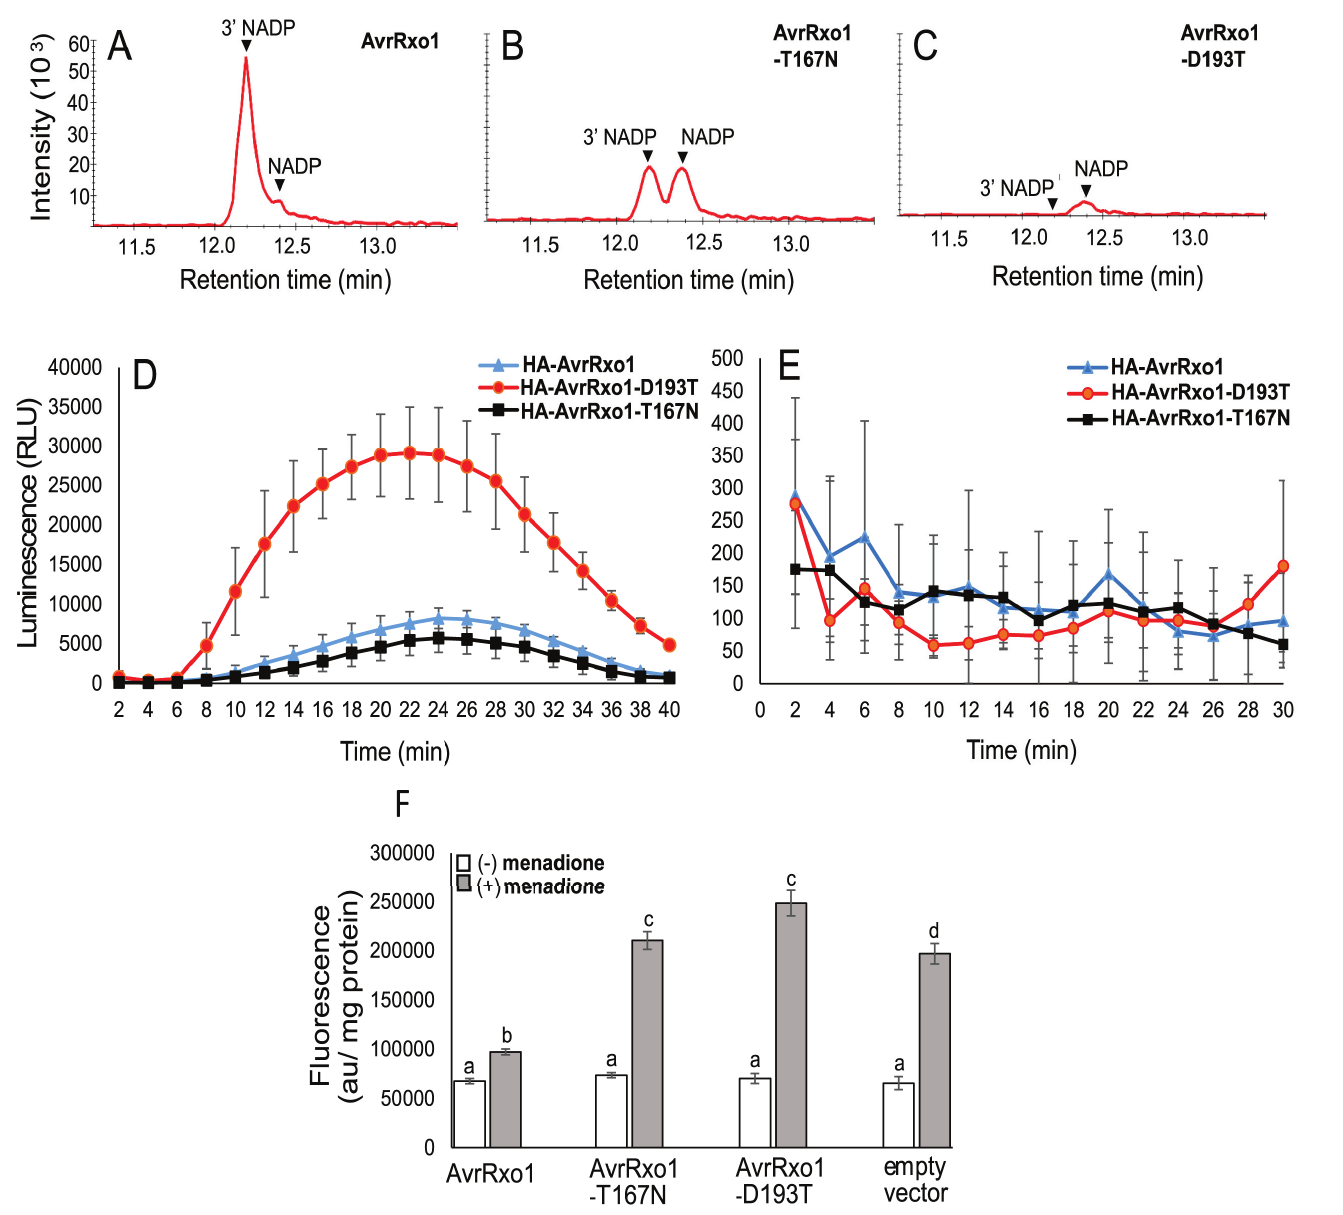
Fig 5. AvrRxo1-T167N retains low NAD kinase activity that allows suppression of flg22-induced oxidative burst in N . benthamiana , but not menadione induced oxidative burst in yeast. (A-C) LC-MS/MS analysisof NADP from yeast cells expressingeither AvrRxo1 (A), AvrRxo1-T167N (B) or AvrRxo1-D193T (C). (D-E) Flg22 (1 μ M) (D) or water (mock) (E) inducedROS burst measuredin leaf discs of N benthamiana transiently expressingeither HA-AvrRxo1, HA-AvrRxo1-D193T or HA-AvrRxo1-T167N. Figure represents mean data of one independentexperiment with three technicalreplicates (mean ± SD; n = 3). Similar results were seen in three independentexperiments. Statistical analysiswas performed using t -test for values corresponding to maximum response. (F) Menadione-inducedintracelluarROS production measured in yeast cells carrying pESC-TRP-AvrRxo1, -AvrRxo1-T167N, -AvrRxo1-D193T or the vector pESC-TRP in inducingmedia. Values were normalized to protein concentration. Figure represents mean data of one independentexperiment with four technicalreplicates(mean ± SD; n = 4). Similar results were seen in three independent experiments.